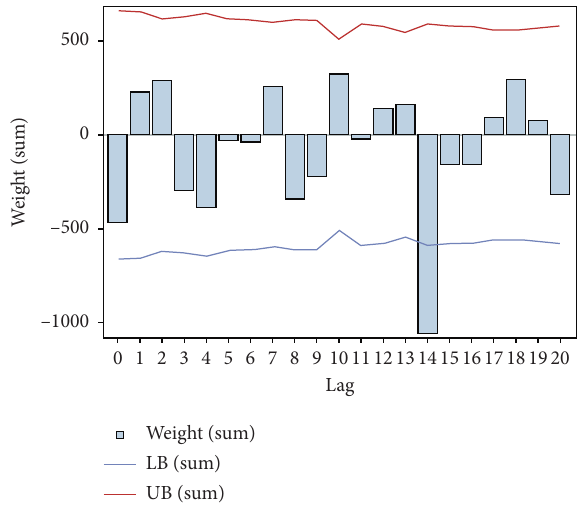
Figure 2: Impulse response weight map of